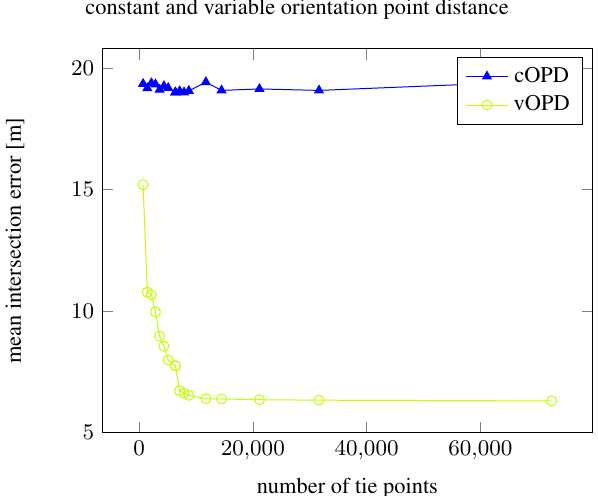
Figure 4: Mean orientation point distance (mOPD) decreases with the number of tie points: Comparison between a constant and variable orientation point distance